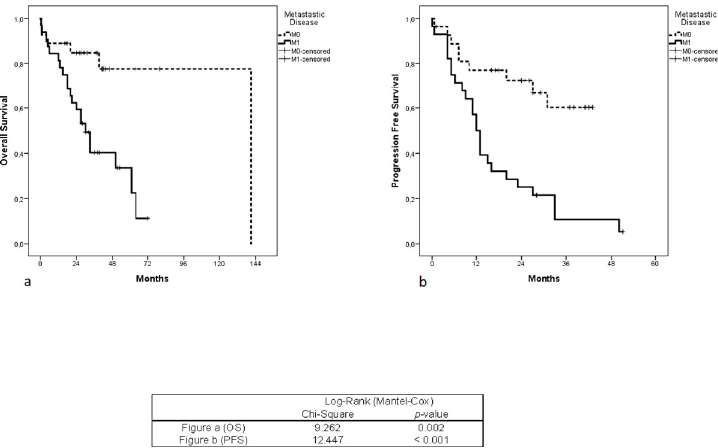
Fig 3. Kaplan-Meier analysis for overall survival and progression-free survival according to metastatic status. Fig (a): Overall survival in patients with CRC, metastatic vs. non-metastatic disease. Fig (b): Progression-free survival in patients with CRC, metastatic vs. non-metastatic disease. P -value Indicates significance according to Log-Rank (Mantel-Cox) test when mCRC is compared to non-mCRC.